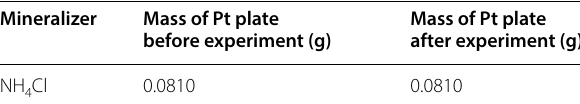
Table 5 Mass of platinum (Pt) plate before and after solubility measurements (conditions: 420 °C, 101